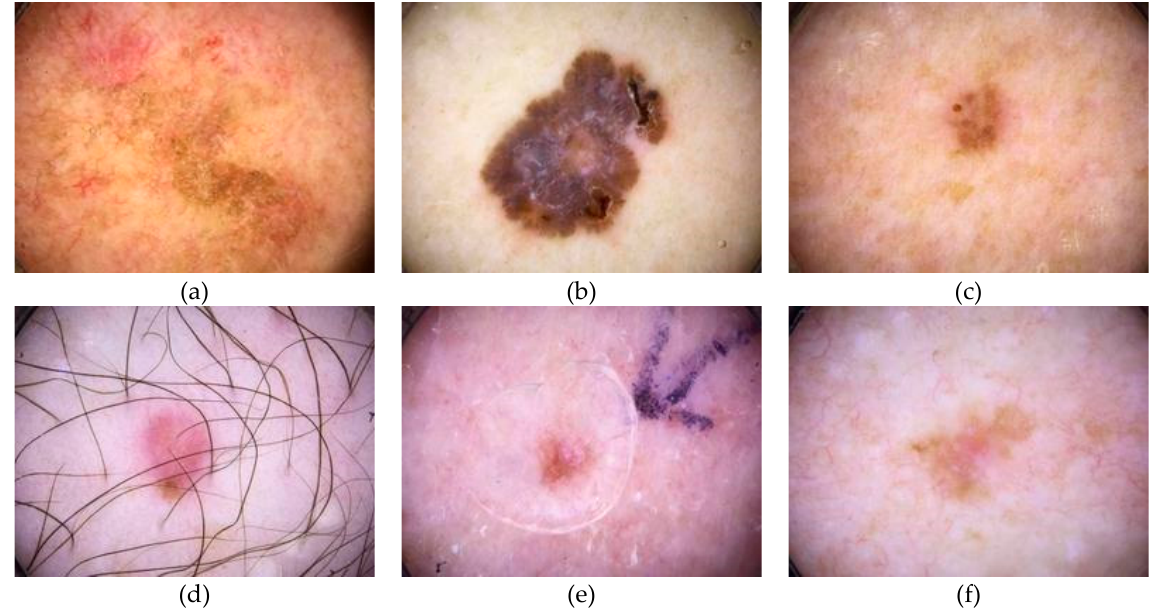
Figure 5. Dermoscopic sample images of skin cancer: ( a ) squamous cell carcinoma, ( b ) basal cell carcinoma, ( c ) benign dermatofibroma, ( d ) benign seborrheic keratosis, ( e ) benign actinic keratosis, and ( f ) malignant melanoma.